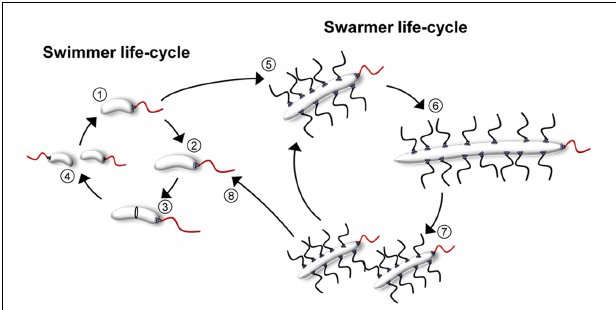
FIGURE 1 | The cell cycles of V. parahaemolyticus . Schematic showing the life-styles and cell-cycles of V. parahaemolyticus . During the swimmer state, cells elongate (1–3) and eventually divide at mid-cell resulting in two progeny swimmer cells (4). Upon surface contact, swimmer cells can differentiate into the filamentous peritrichously flagellated swarmer cells (5). Swarmer cells can either continue the swarmer life-style, where division events result in swarmer progeny cells (5–7); alternatively swarmers can de-differentiate back into swimmer cells (8) and re-enter the swimmer cell cycle